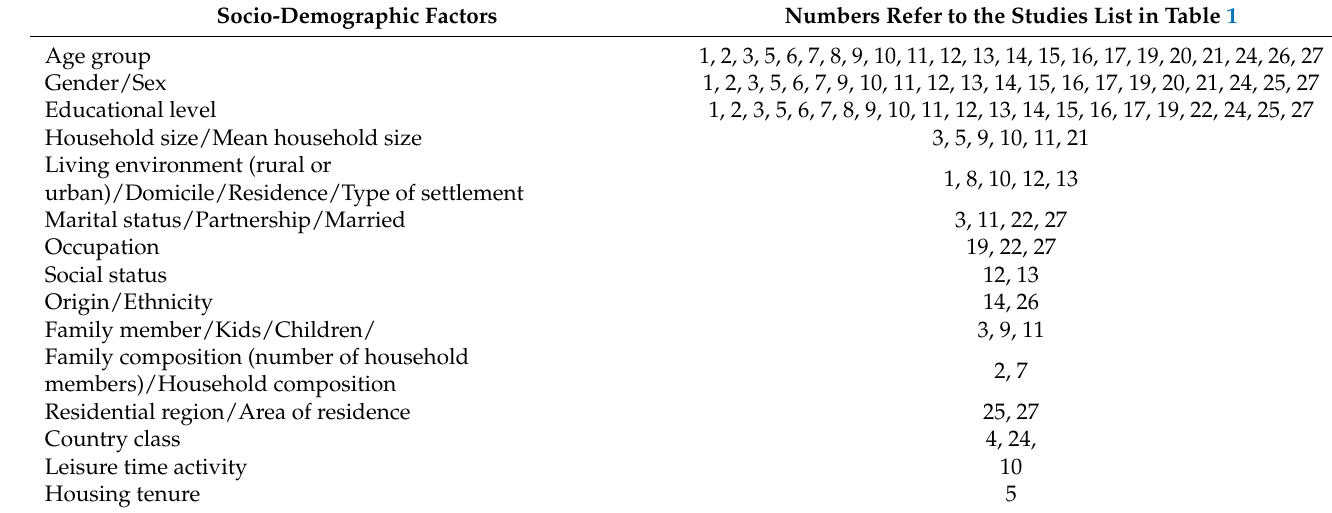
Table 2. Socio-demographic factors used in the analyzed